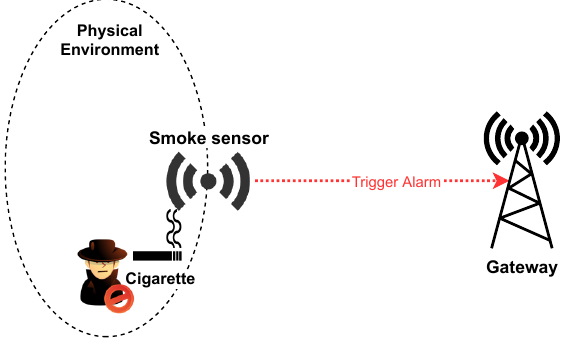
Figure 6. Example of physical-related